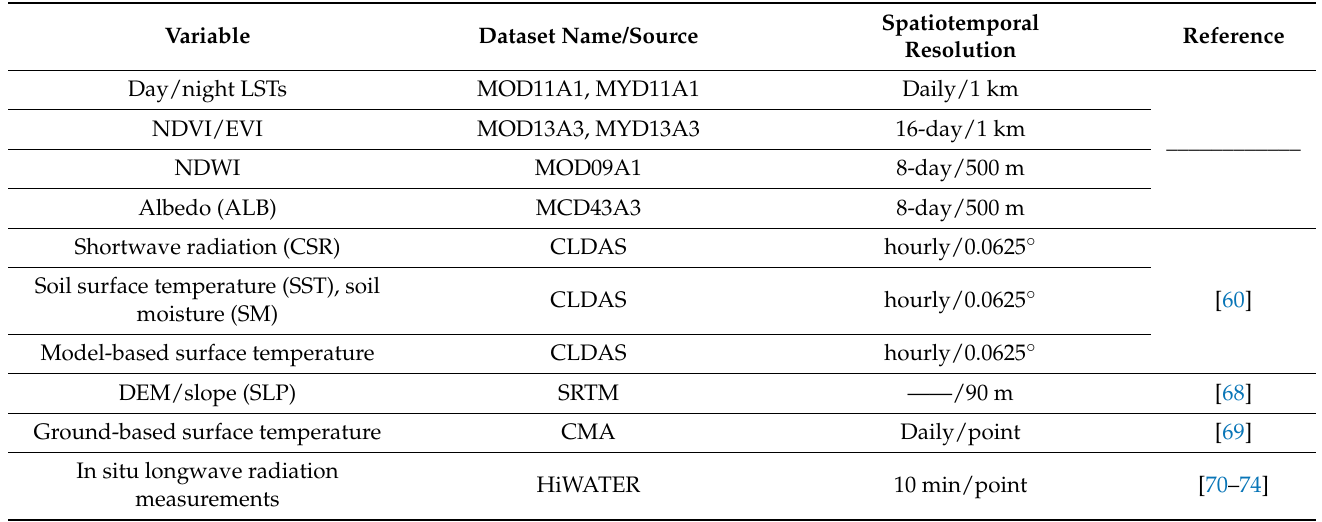
Table 2 gives an overview of the datasets used in this study, including the variable types, dataset name/source, and the spatiotemporal resolution. Table 2. Datasets used to develop and validate the reconstruction algorithm in this